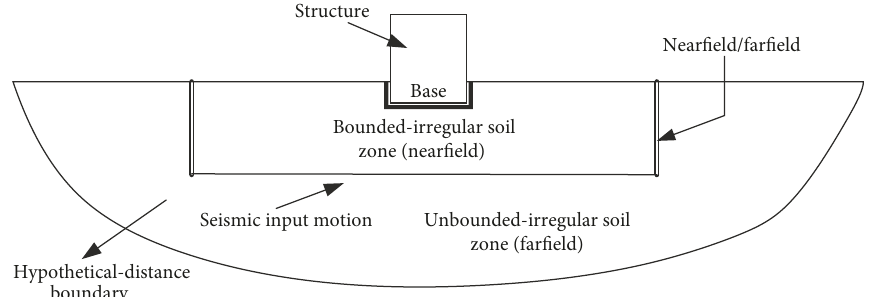
Figure 8: Components of a system of soil and structure interaction [48].